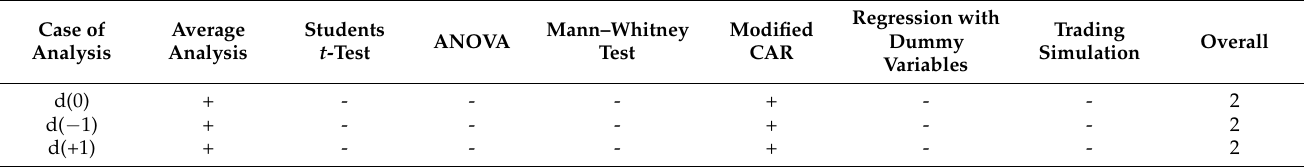
Table 1. Overall results for expiration price effects: the daily